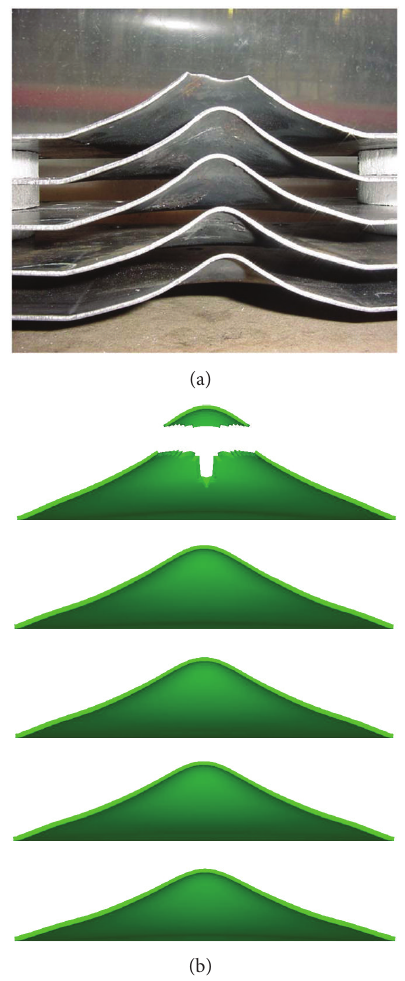
Figure 6: Comparison of cross sectional profiles of (a) experiments [22] and (b) proposed simulations. The test numbers from bottom to top are N021100124, N01100123, N22100145, N01100121, and